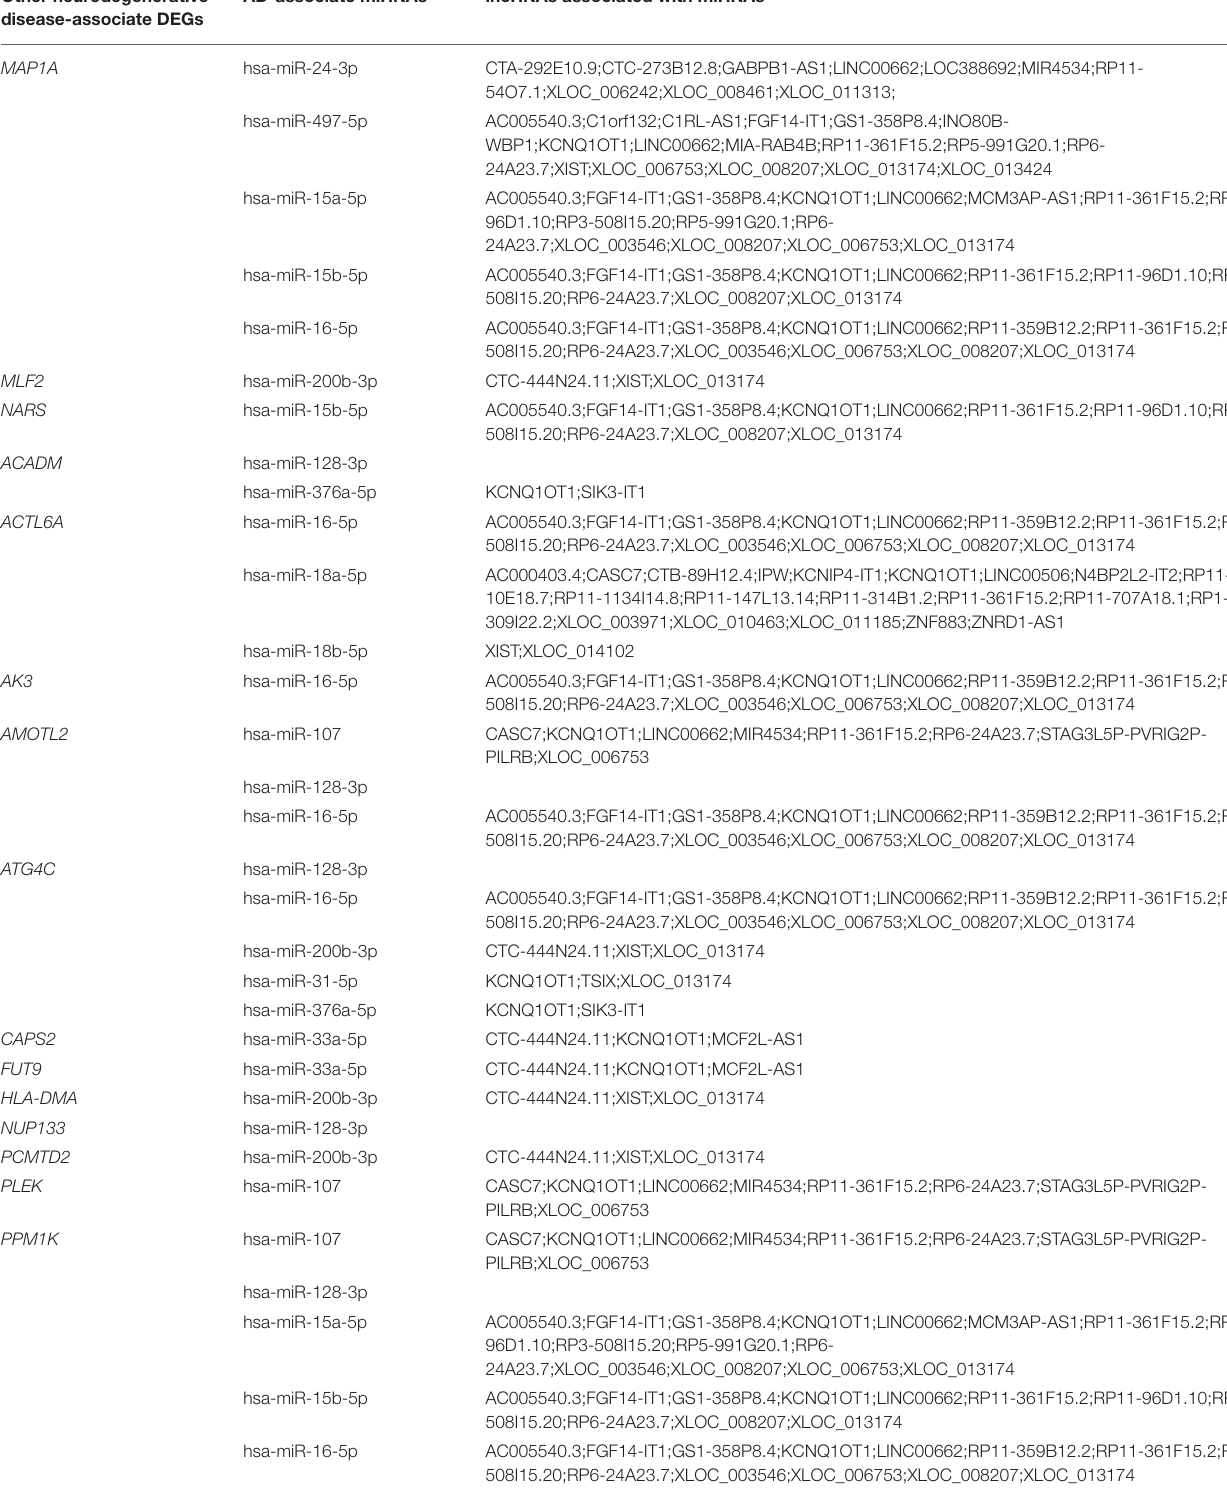
TABLE 9 | AD-associate miRNAs associated with other neurodegenerative disease-associate DEGs. Other neurodegenerative AD-associate miRNAs lncRNAs associated with disease-associate DEGs